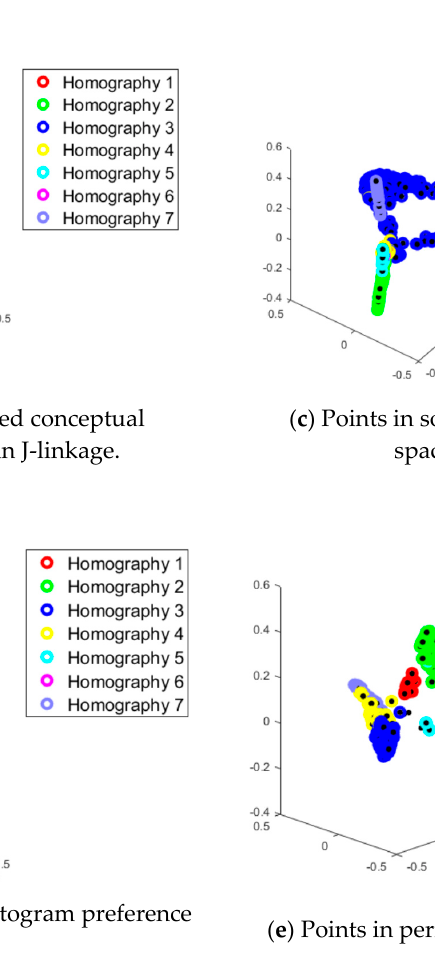
Figure 5. MDS (Multiple Dimensional Scaling) plots for “johnsonb” without outliers by using different preferences.